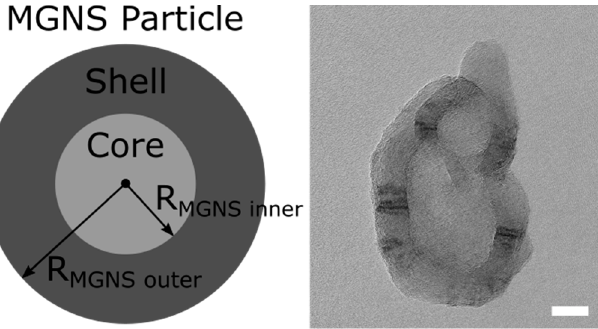
Figure 3. Diagram of an idealized MGNS particle ( left ) and a TEM image of an actual MGNS particle ( right ). Scale bar indicates 10 nm.